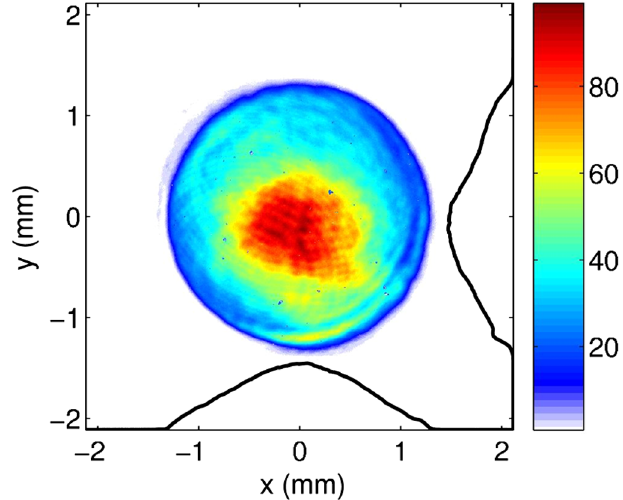
FIG. 6. (Color) A typical transverse laser profile. The black solid lines show the projected horizontal and vertical profiles.